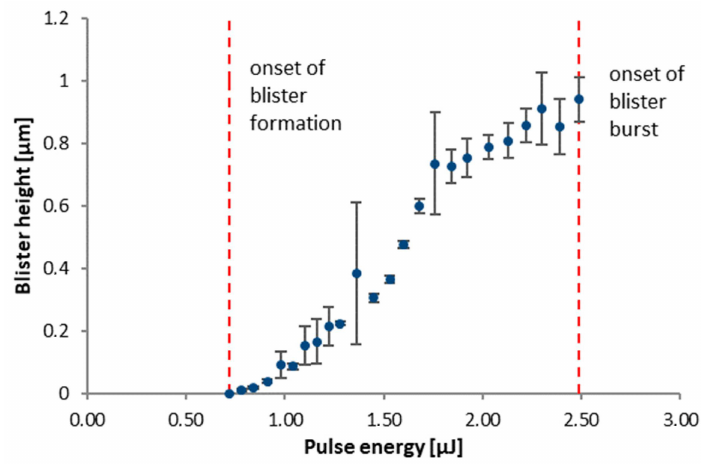
Figure 5. Height of the laser induced blisters in polyimide film with d PI = 3.5 µ m as a function of the pulse energy E p ( λ = 515 nm laser wavelength with shaped beam). Error bars indicate standard deviation obtained from 6